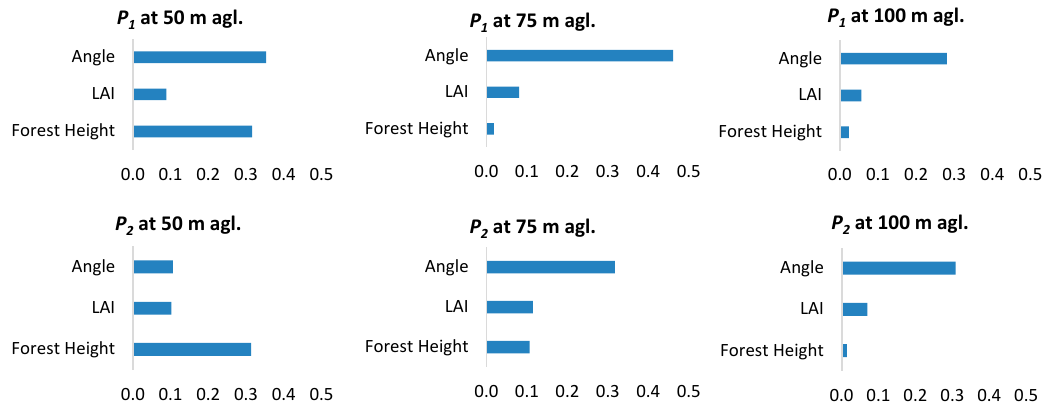
Figure 6. Pareto chart of effects for the horizontal velocity at different altitudes on 𝐿 1 and 𝐿 2 .